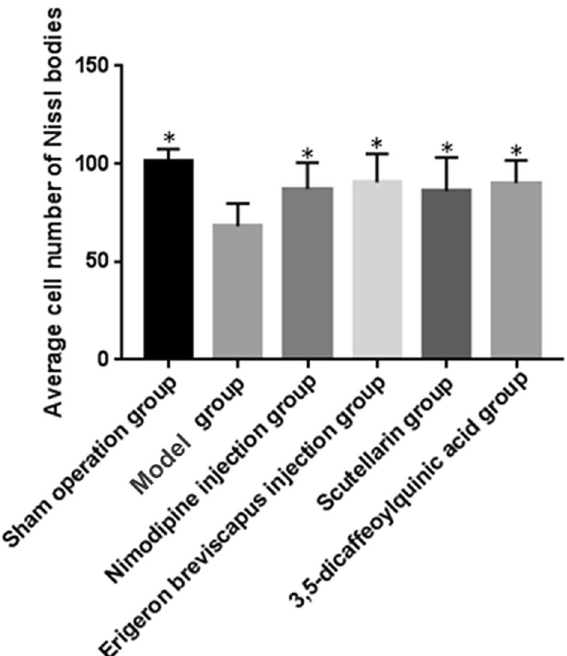
Figure 6. Average number of Nissl somatic cells in the ischemic brain tissues of rats. The values are presented as mean ± SD. (n = 6), * compared with the model group, * P < 0.05 and ** P < 0.01.